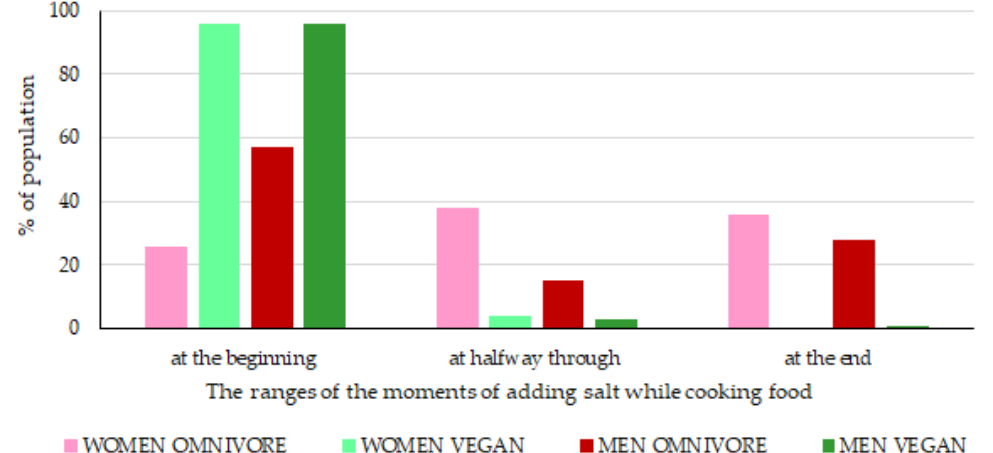
Figure 5. The time (at the beginning, halfway through, the end) to add salt to food while cooking among women and men with the vegan diet and the omnivore diet aged 18 – 80 from